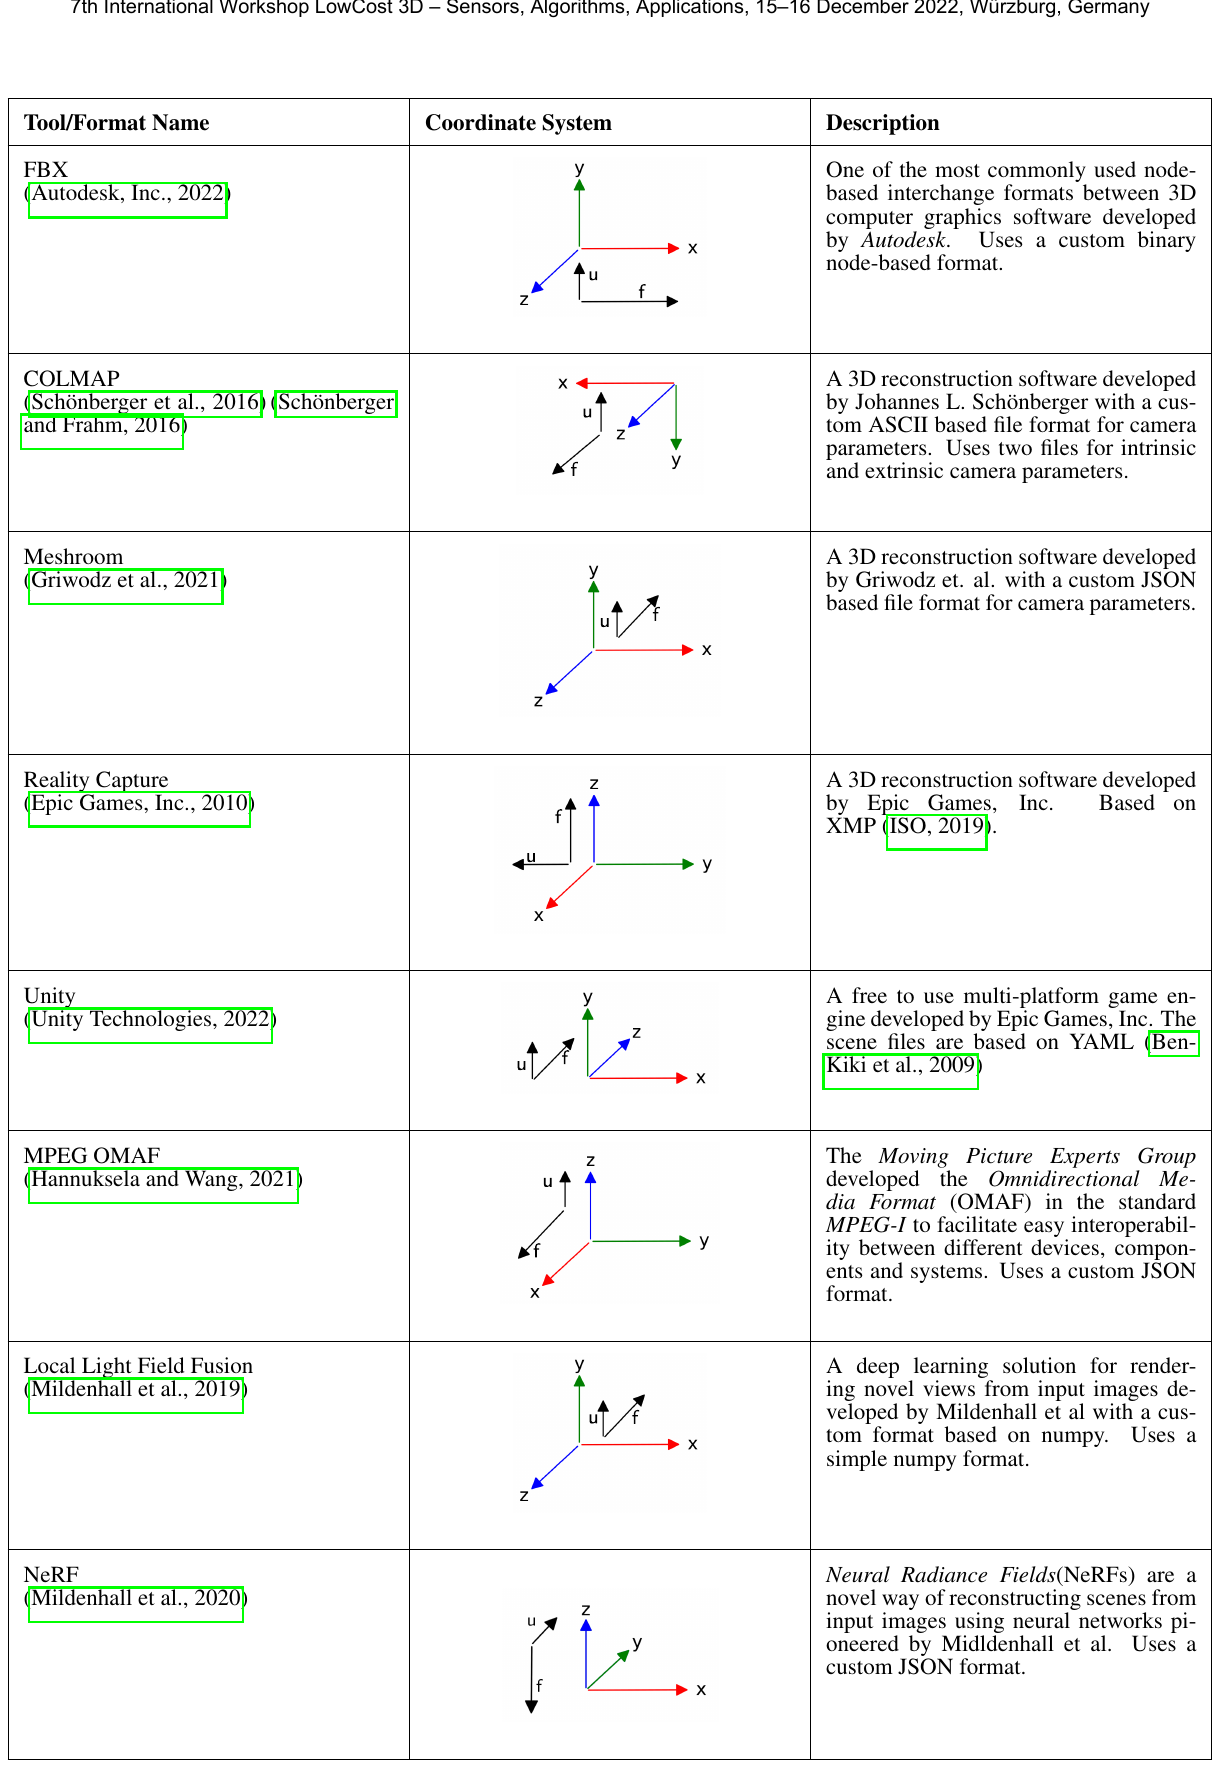
Table 1. Supported formats in camorph. u marks the default cameras up vector, while f marks the front